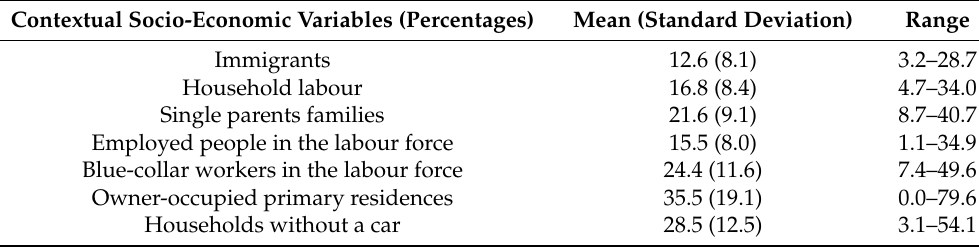
Table A1. Contextual socioeconomic characteristics defined at the census block groups level ( n =